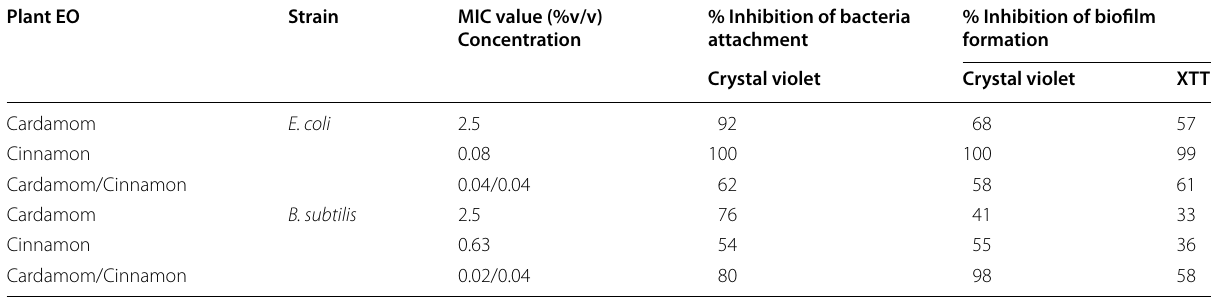
Table 3 Antibiofilm activity of cardamom and cinnamon essential oils and their combination on inhibition of initial bacteria cell attachment and biofilm formation (growth and development) Plant